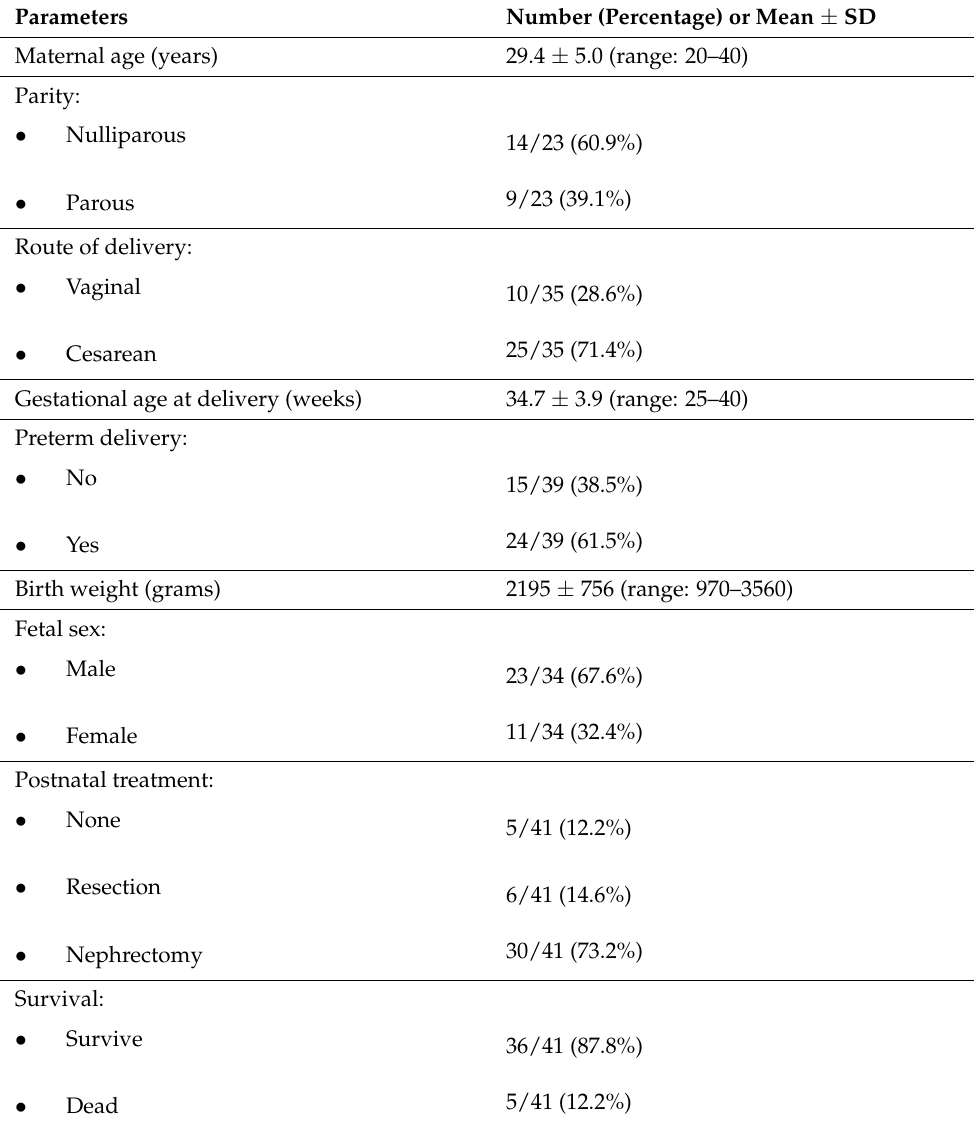
Table 3. Summary of pregnancy baseline and